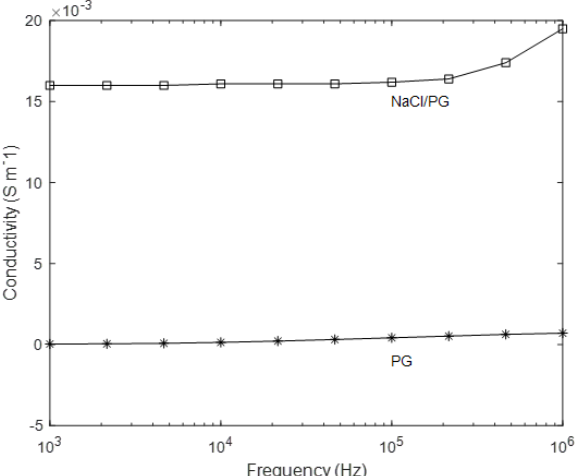
Figure 1. Electrical conductivity of pure PG and NaCl/PG solution in the frequency range between 1 kHz and 1 MHz.